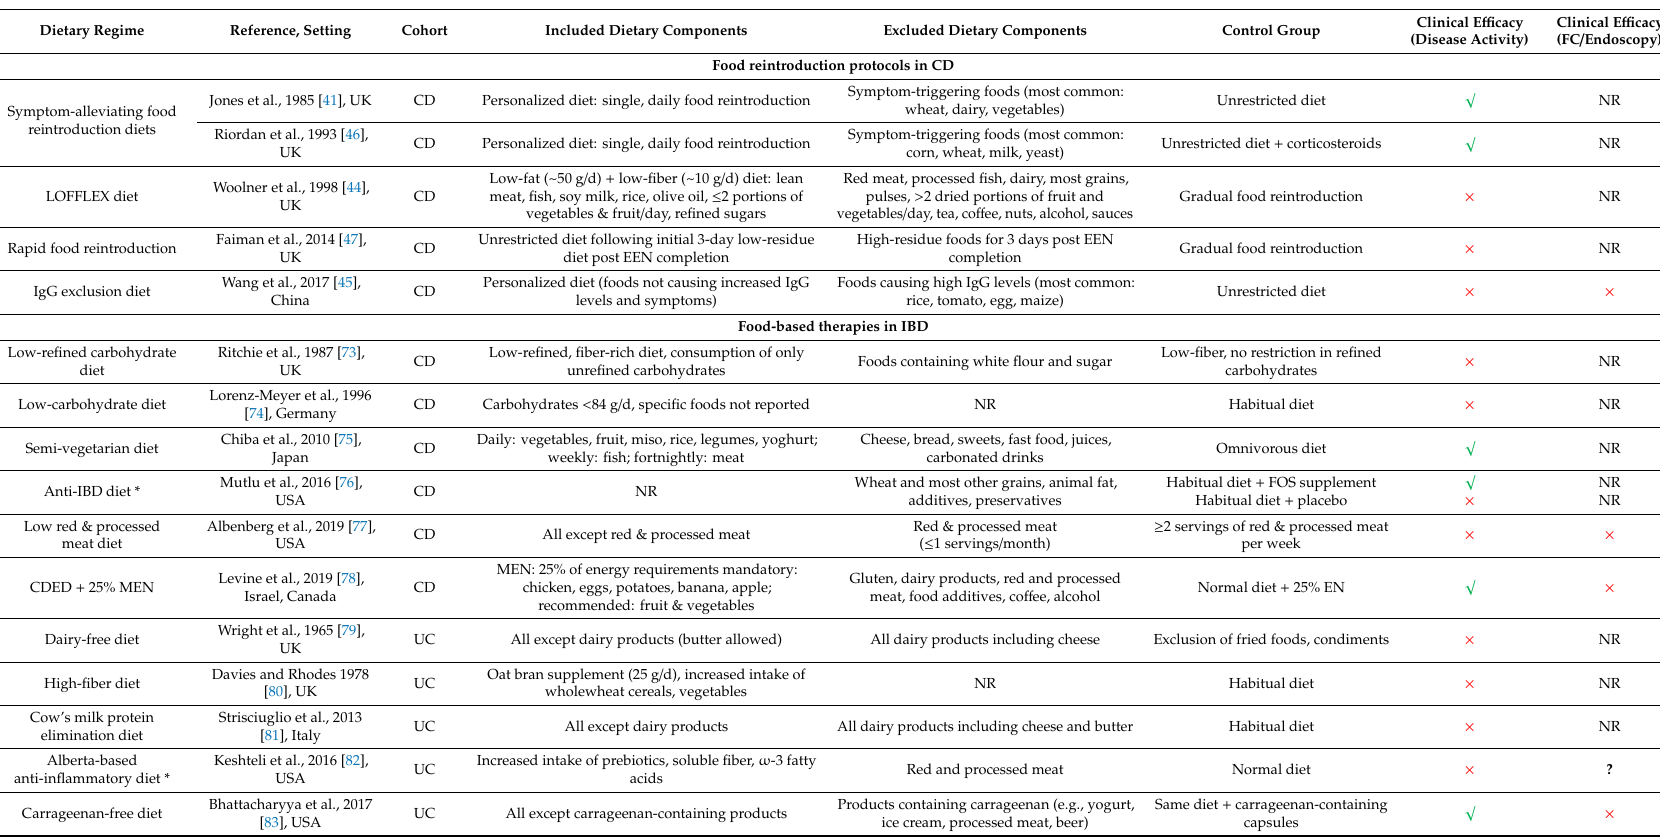
Table 1. Summary of food reintroduction protocols and food-based dietary therapies which have been used as a strategy for maintenance of clinical remission in IBD in studies which included a control